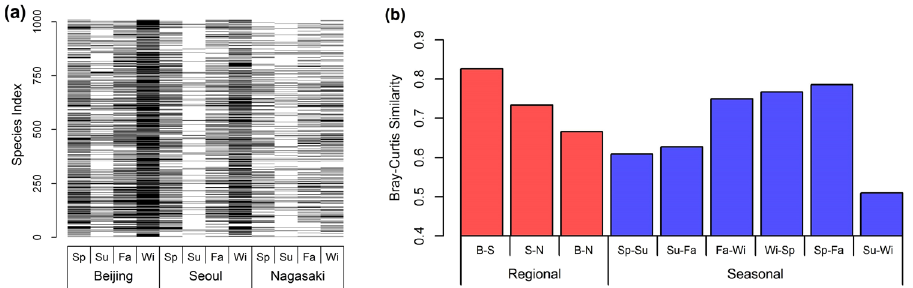
Figure 4. ( a ) Heat map of the identified phylotypes at the genus level, where identified phylotypes are in black and unidentified phylotypes are in white. Sp., Su., Fa., and Wi. indicate the four seasons (spring, summer, fall, and winter), respectively. ( b ) Bray-Curtis similarities of the identified phylotypes at the genus level between measurements sites and between seasons. B-S, S-N, and B-N represent comparisons between Beijing and Seoul, Seoul and Nagasaki, and Beijing and Nagasaki, respectively. Sp., Su., Fa., and Wi. indicate the four seasons,